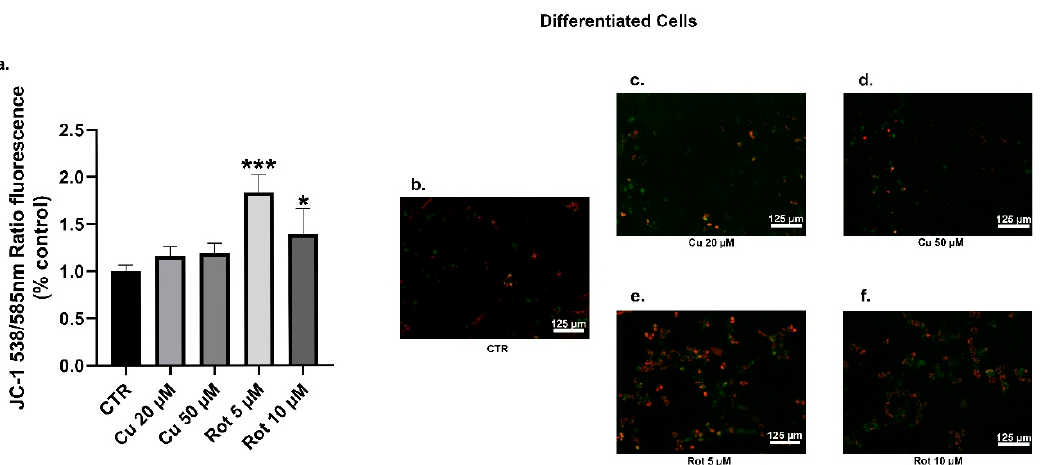
Figure 13. Differentiated SHSY5Y cells JC-1 analysis. The JC-1 staining was used to assess the MMP. Cells were treated with 20 or 50 µ M copper ( c , d ) or 5 or 10 µ M rotenone ( e , f ) and compared to untreated cells ( b ). The percentages of JC-1 monomers presented the percentages of SHSY5Y cells with low MMP. Fluorescence values were normalized on total protein ( a ). Values were compared with untreated cells (CTR) by one-way ANOVA following Tukey test * p < 0.0332 *** p < 0.0002.